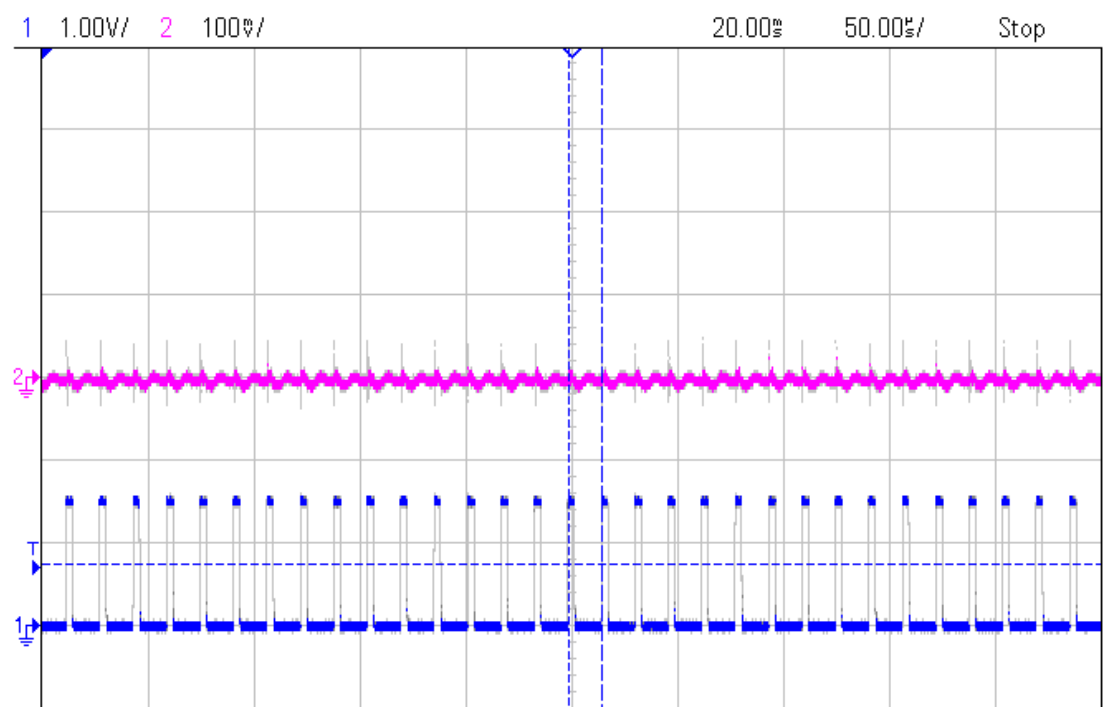
Figure 13. Output voltage ripple (upper plot) and PWM (bottom plot) respectively for PI closed-loop nominal operation.